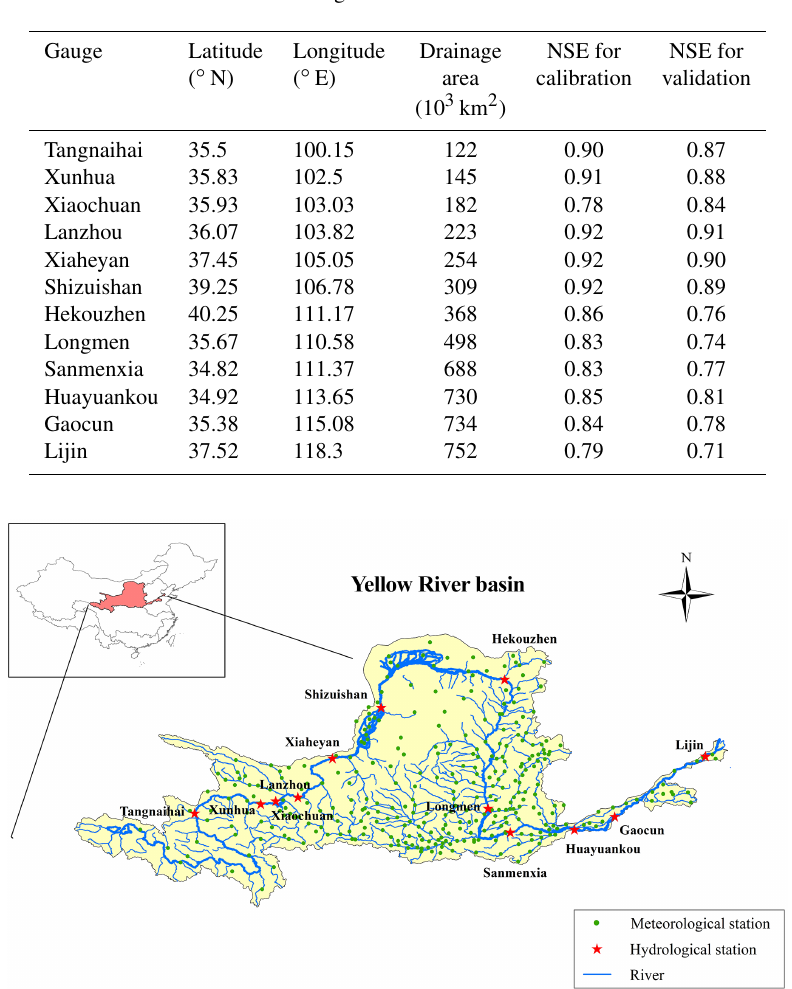
Table 1. Information at 12 hydrological gauges and the Nash–Sutcliffe efficiency (NSE) during the periods of calibration (1961–1981) and validation (1982–2010). The simulated streamflow is verified against naturalized streamflow.